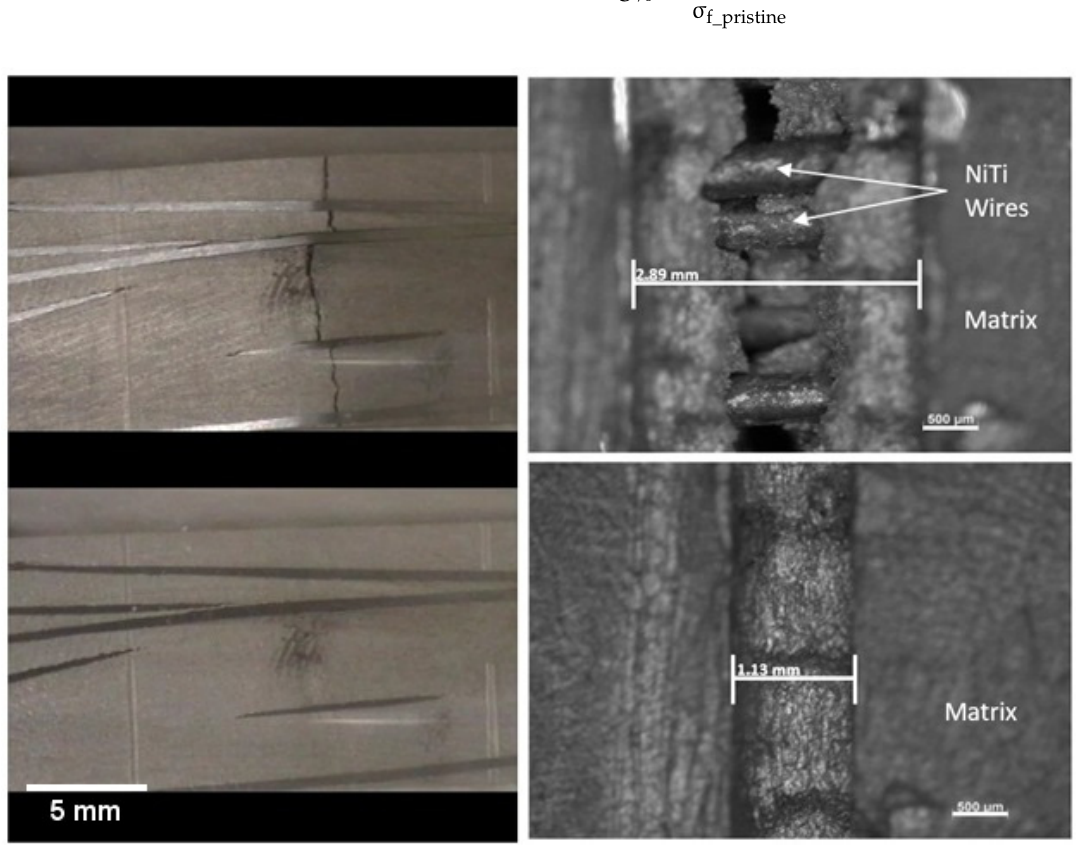
Figure 7. Photographs of smooth ( left ) and notched ( right ) specimens in cracked ( top ) and healed ( bottom ) states. Reprinted/adapted with permission from Ref. [20]. 2013, Shobhit Misra.